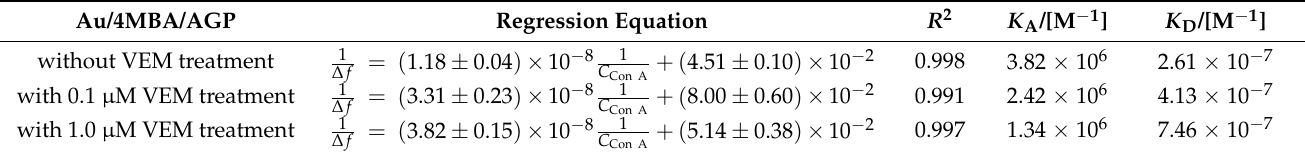
Table 2. Calibration equations and values of K A and K D for AGP layer untreated and treated with VEM. Au/4MBA/AGP Regression Equation R 2 K A /[M − 1 ] K D /[M − 1 ] without VEM treatment with 0.1 µ M VEM treatment with 1.0 µ M VEM